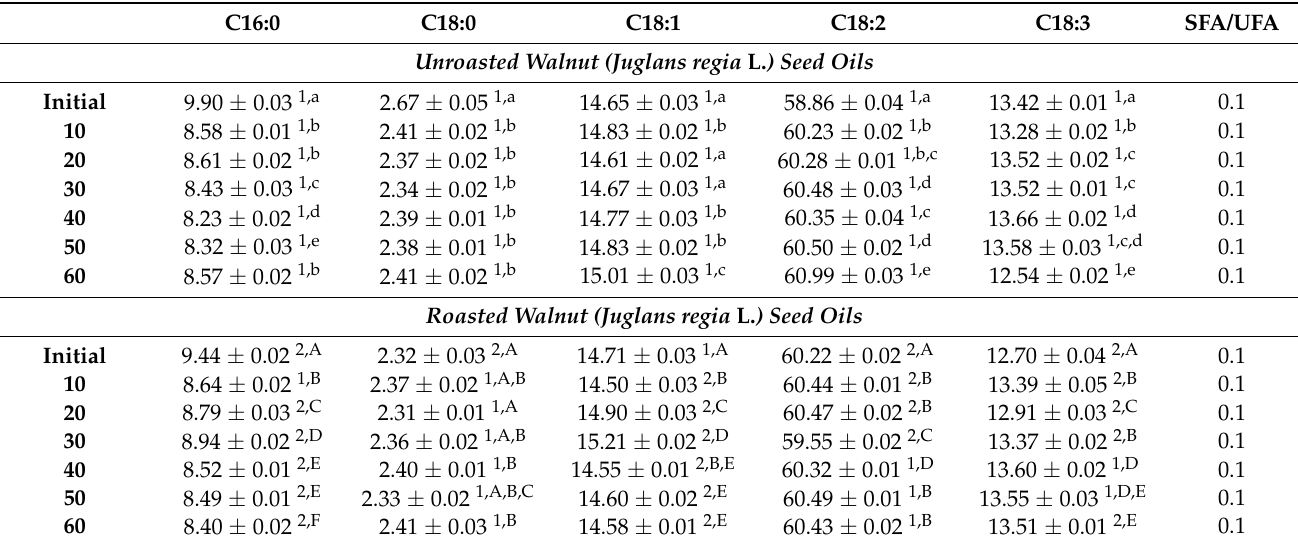
Table 1. The fatty acid composition (%) of UWO and RWO during 60 days of storage at 60 ± 2 ◦